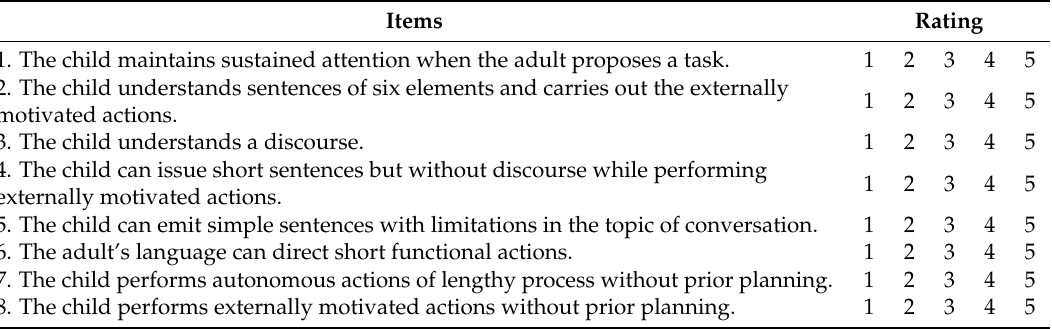
Table A1. S cale of assessment of metacognitive precursors